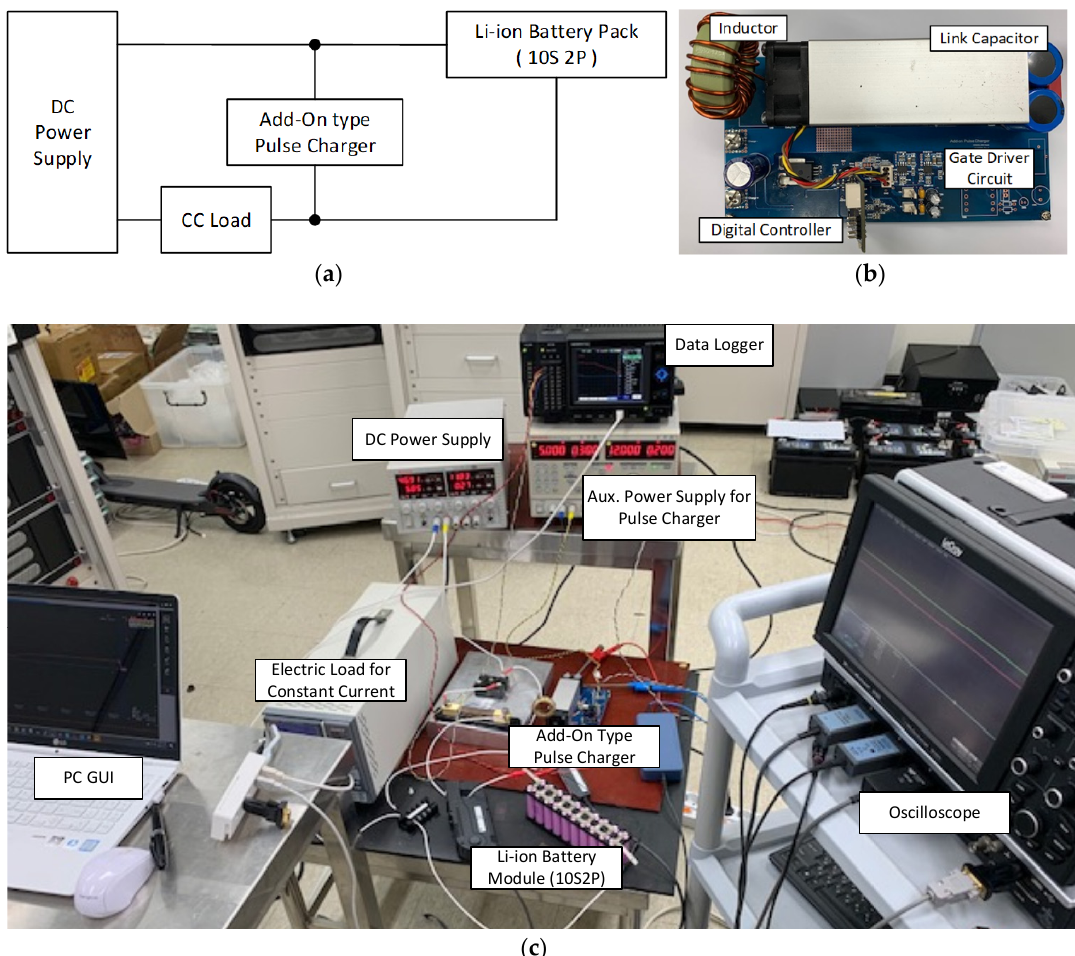
Figure 12. Experiment set configuration. ( a ) Block diagram of the experiment set, ( b ) prototype of the add ‐ on type pulse charger and ( c ) experiment environment.